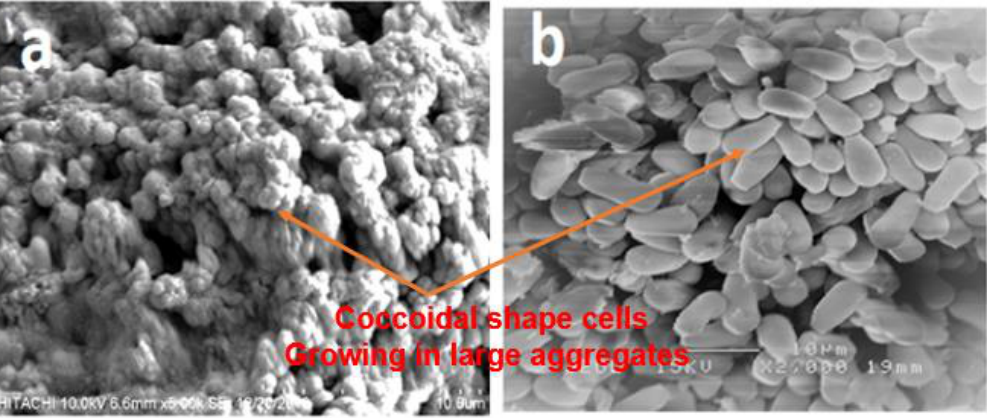
Figure 14. Image of granules from the sludge bed in the HUASB section: ( a ) aggregates of coccus which form the granule before pre-treatment and ( b ) attachment of microbes on synthetic grass after pre-treatment.